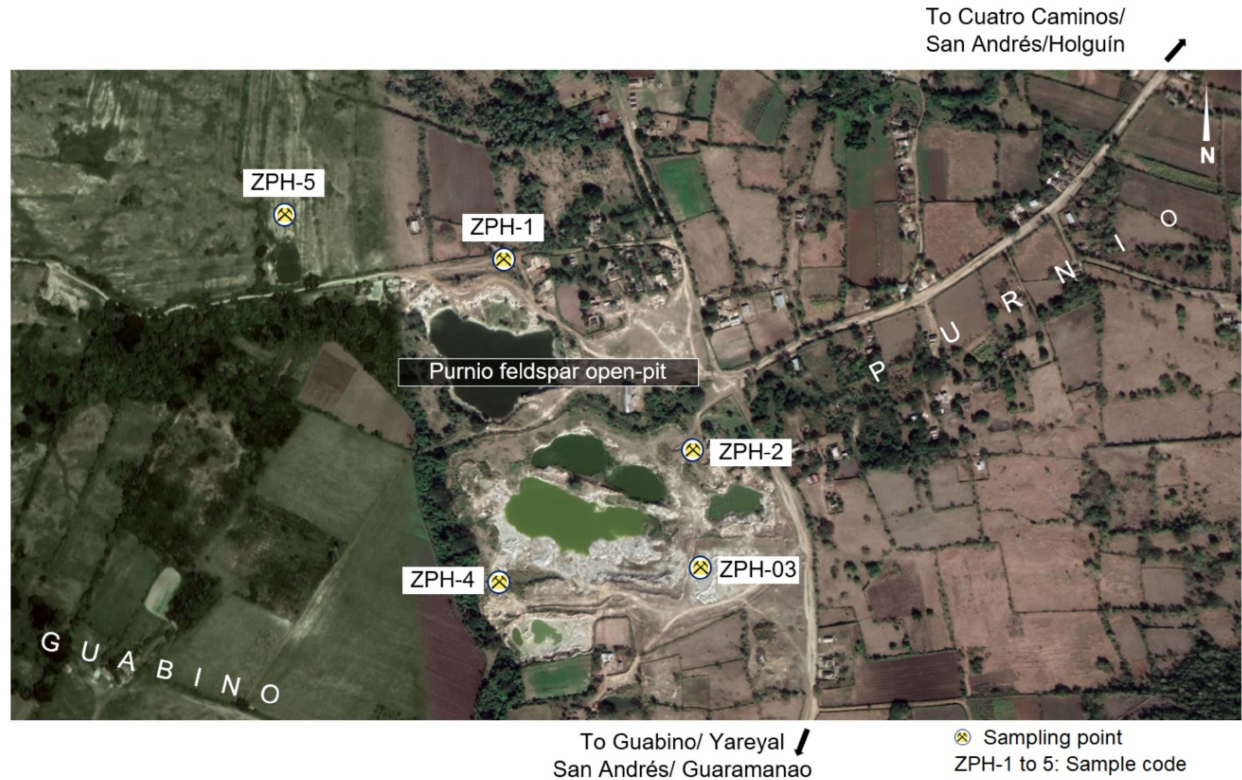
Figure 7. Location of the sampling places